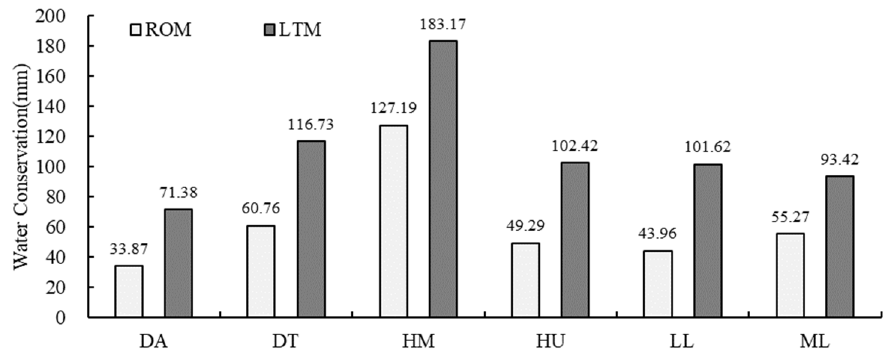
Figure 11. Comparison of average water conservation in different sub-watersheds.